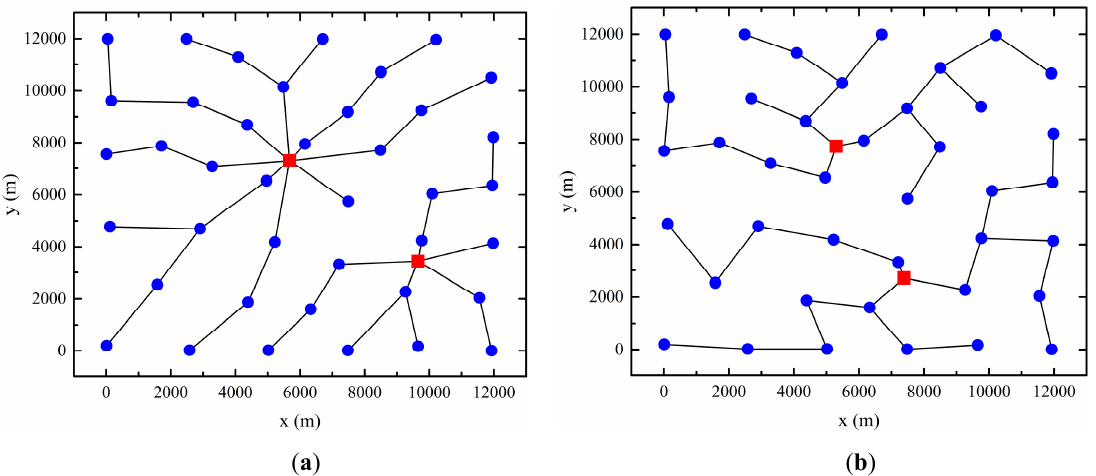
Figure 9. Optimized topology for a substation condition by ( a ) the integration method and ( b ) the two-step method.